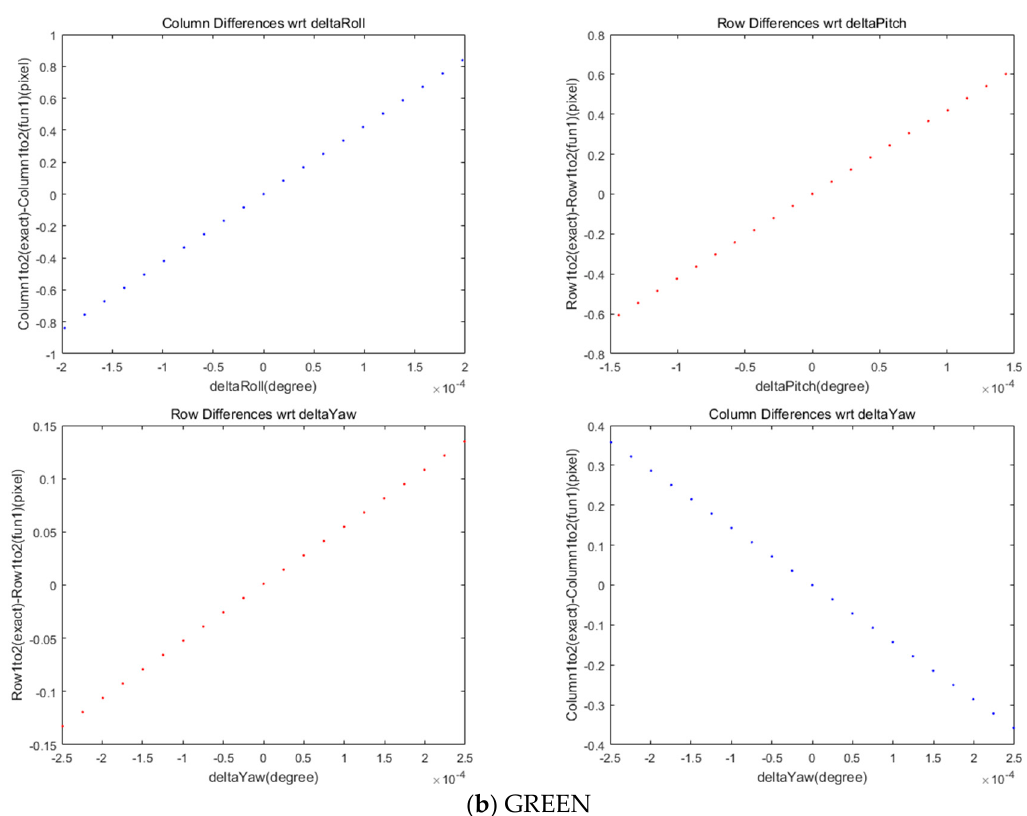
Figure 8. Differences in rows and columns in coordinates between MS and PAN images for attitude Figure 8. Di ff erences in rows and columns in coordinates between MS and PAN images for changes. attitude changes. Table 6. Standard deviations in the coordinate differences between MS and PAN images for attitude changes.